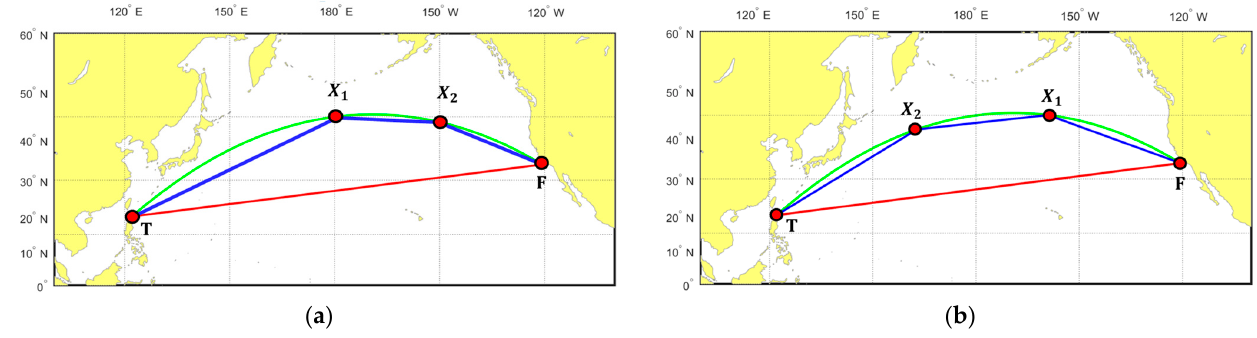
Figure 8. Comparison of position distribution when there are two waypoints: ( a ) the LBM and ( b ) the GA method.